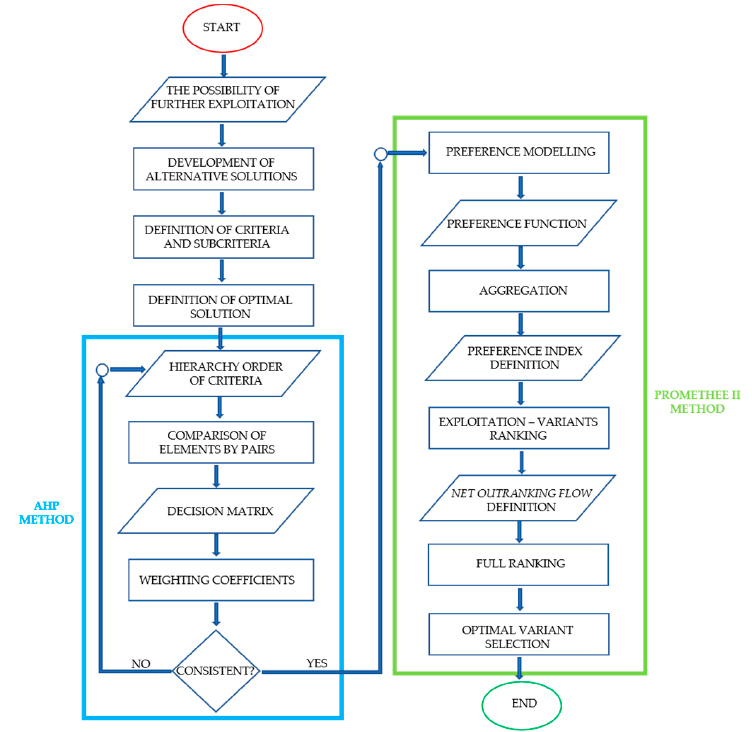
Figure 1. Algorithm for combined usage of AHP and PROMETHEE II methods.